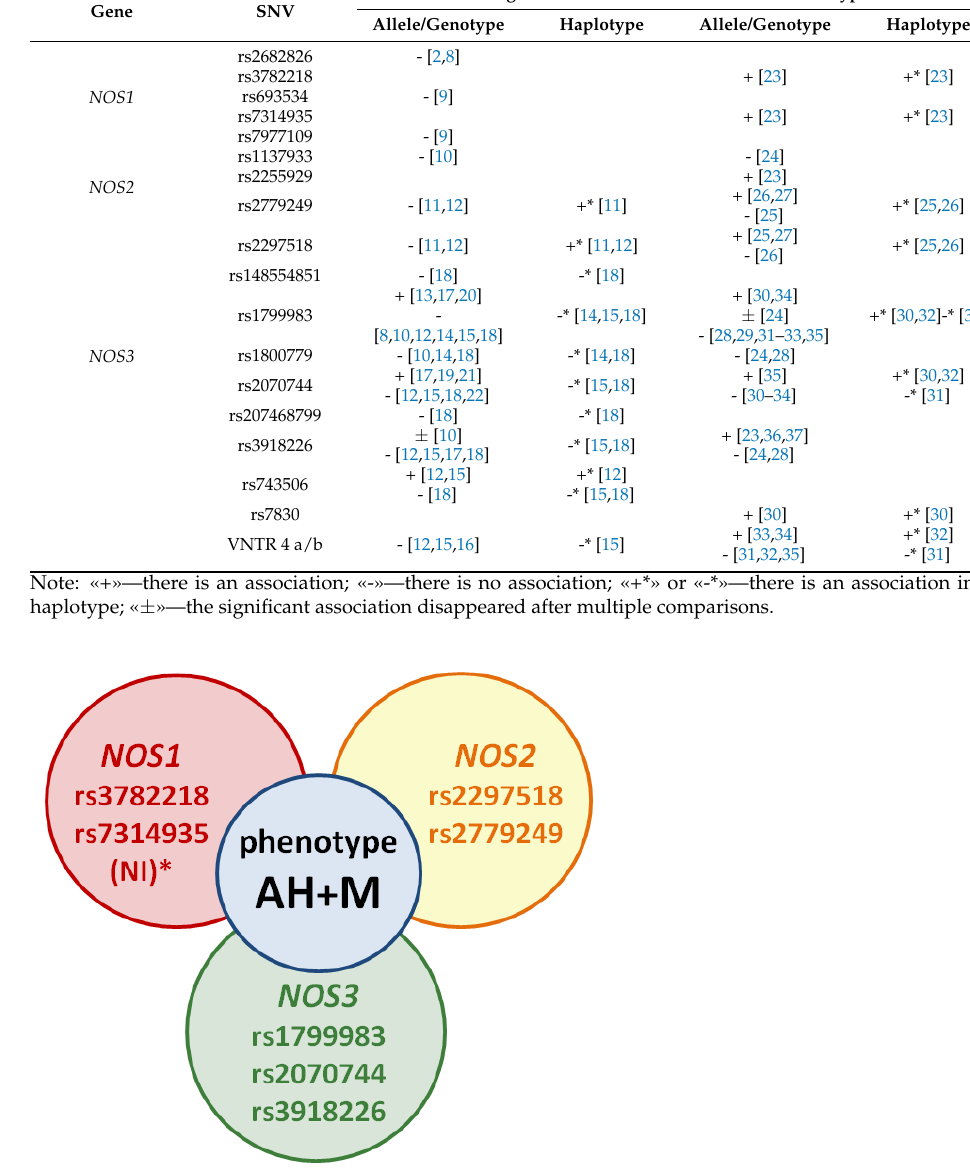
Figure 3. The scheme of the migraine and arterial hypertension phenotype: NI *—no or not enough information—SNVs’ studies on migraine versus AH are not available, but these SNVs may be potential markers of the phenotype in future studies. Table 1. Association of genes NOS1 , NOS2 , and NOS3 SNVs with the development of M and AH.